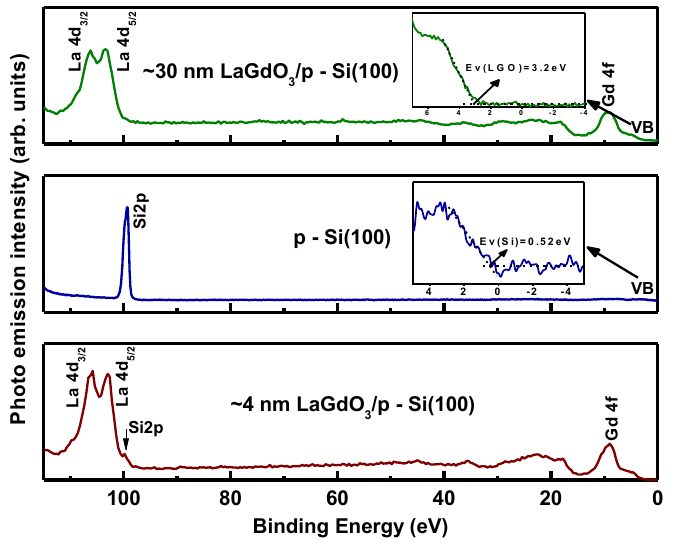
Figure 12. The XPS spectra of shallow core levels and valence band in the ~4-nm LaGdO /Si ultra-thin film, HF-last dipped p-Si (100) and the ~30-nm LaGdO 3 (bulk oxide). The high-resolution scans of the silicon and LaGdO shown in the inset. Reprinted with permission from [19]. Copyright 2012 AIP Publishing